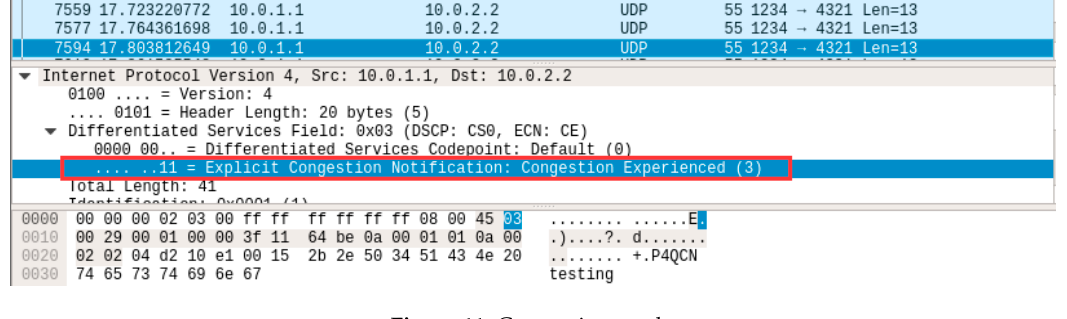
Figure 11. Congestion mark.